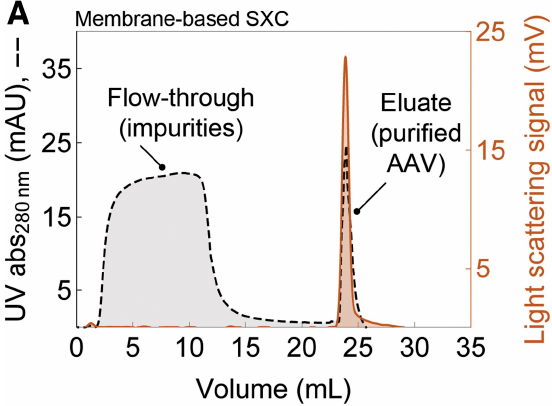
Figure 3. Example chromatogram of SXC purification of AAV2 with a liquid chromatography system comprising UV and light-scattering signal. Light-scattering signal detects AAV particles. Figure extracted from [18].